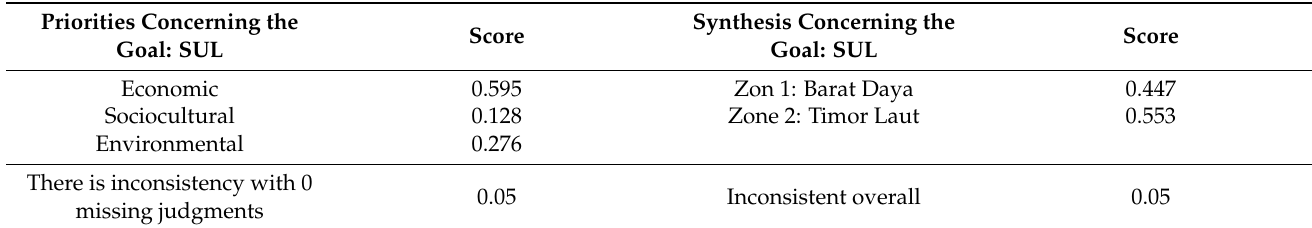
Table 4. Final weights for Penang Island’s urban landscape